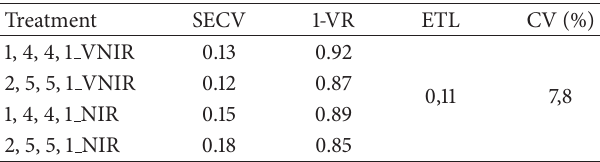
Table 4: Comparison between the errors obtained by VNIR, NIR, and the standard error of the reference method (Kappa